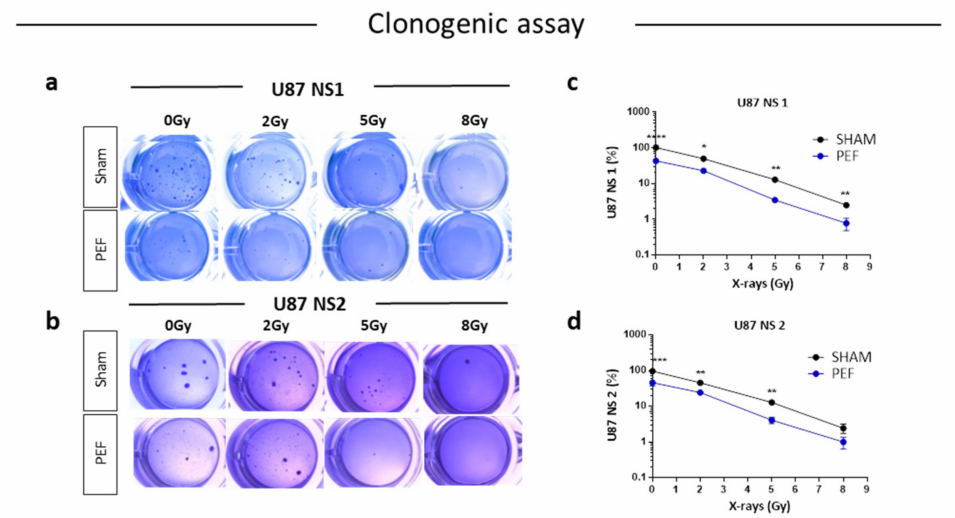
Figure 5. Survival clonogenic assay. ( a , b ) Representative images of primary and secondary neuro- spheres after PEF-5 exposure and IR treatments. ( c , d ) Quantitative analysis revealed a significant decrease in the clonogenic capacity between sham- and PEF-5 exposed cells, regardless of culture conditions. The combined treatment (PEF-5 + IR) reduced clone formation as a function of deliv- ered radiation doses. p values were determined using a two-tailed t test. * p < 0.05; ** p < 0.01, **** p <